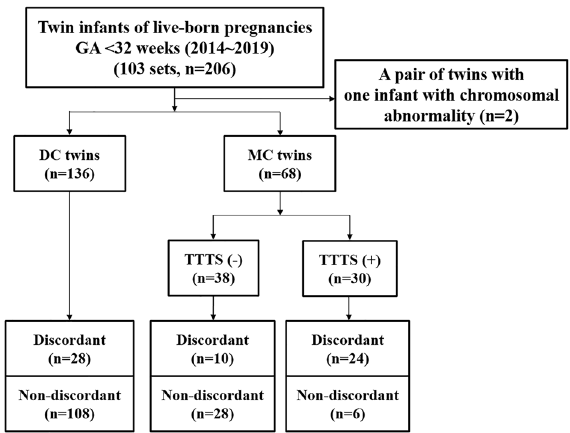
Figure 1. Flow chart of the study